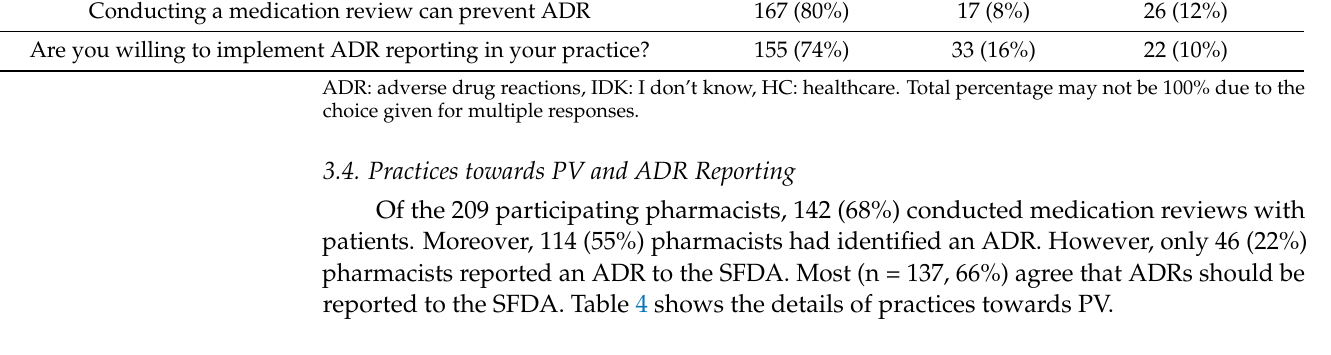
Table 4. Practice towards PV and ADRs reporting.